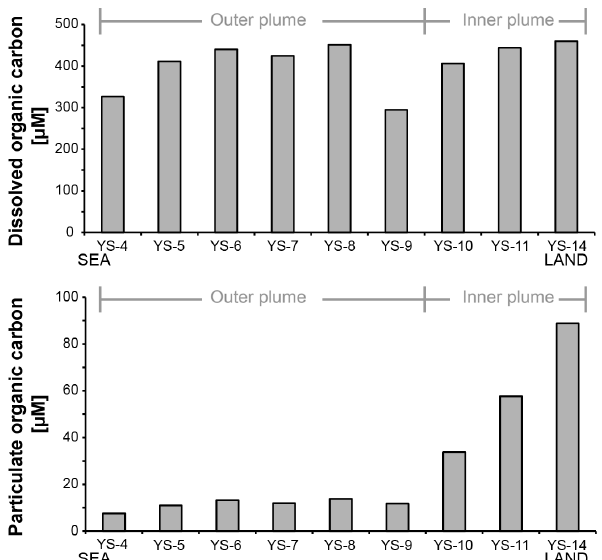
Figure 3. Dissolved ( < 0 . 70µm) and particulate ( > 0 . 70µm) or- ganic carbon concentrations along the Lena River–Laptev Sea tran- sect. Close to the Lena River mouth, POC constitutes about 18% of the TOC input, while at the outermost station it is only 2% of the TOC.